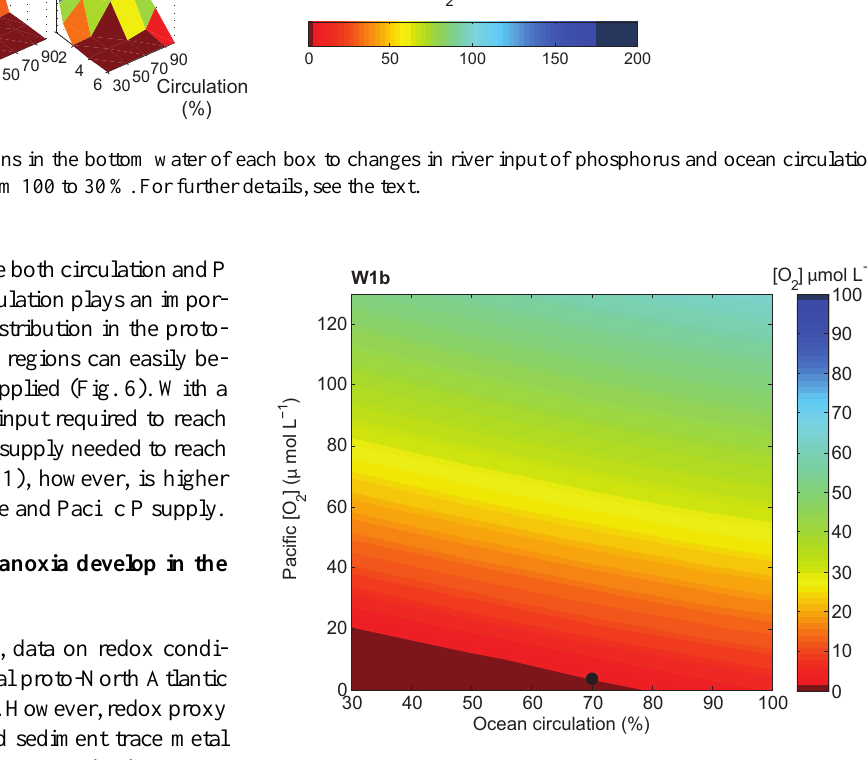
Fig. 7. Sensitivity of oxygen concentrations in the bottom water of the central open ocean (W1) to ocean circulation and changes in oxygen concentrations in Pacific bottom water. The black dot indicates the run where most of the proto-North Atlantic is anoxic with an ocean circulation of 70%